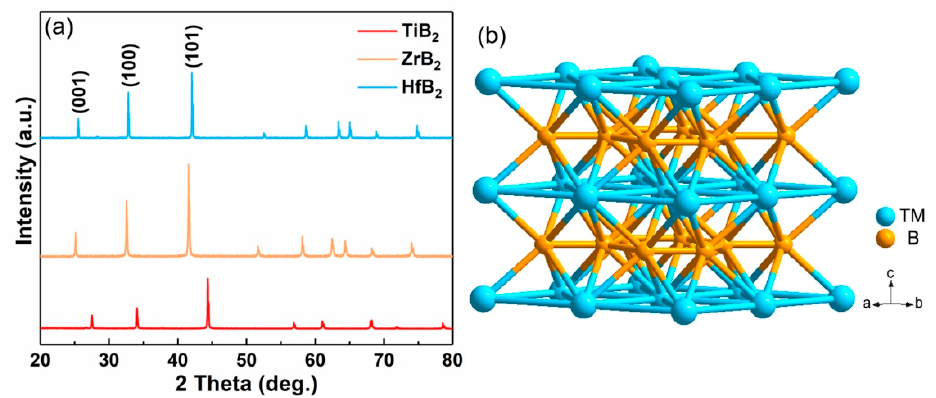
Figure 1. ( a ) The XRD of TiB 2 , ZrB 2 and HfB 2 modified by HPHT, and ( b ) the crystal structure of AlB 2 type materials.